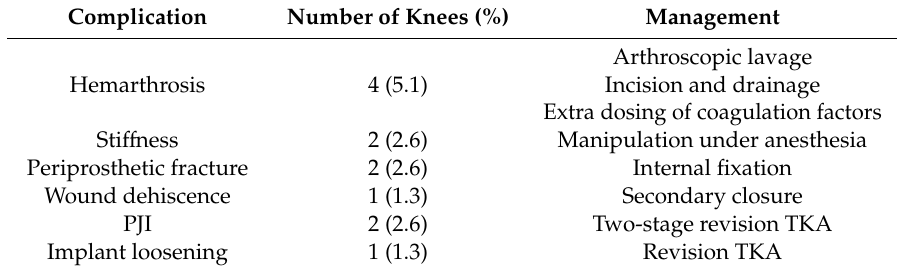
Table 7. Postoperativecomplicationafterprimarytotalkneearthroplasty(TKA)inhemophilicarthropathy a .